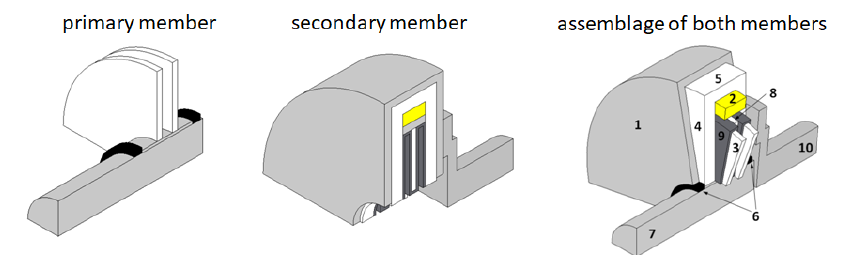
Figure 1. Main view of a two-disc (N = 2) MR clutch: 1—non-magnetic housing, 2—coil, 3—discs of primary member, 4—cover yoke, 5—cylinder yoke, 6—bearings, 7—non-magnetic shaft—primary